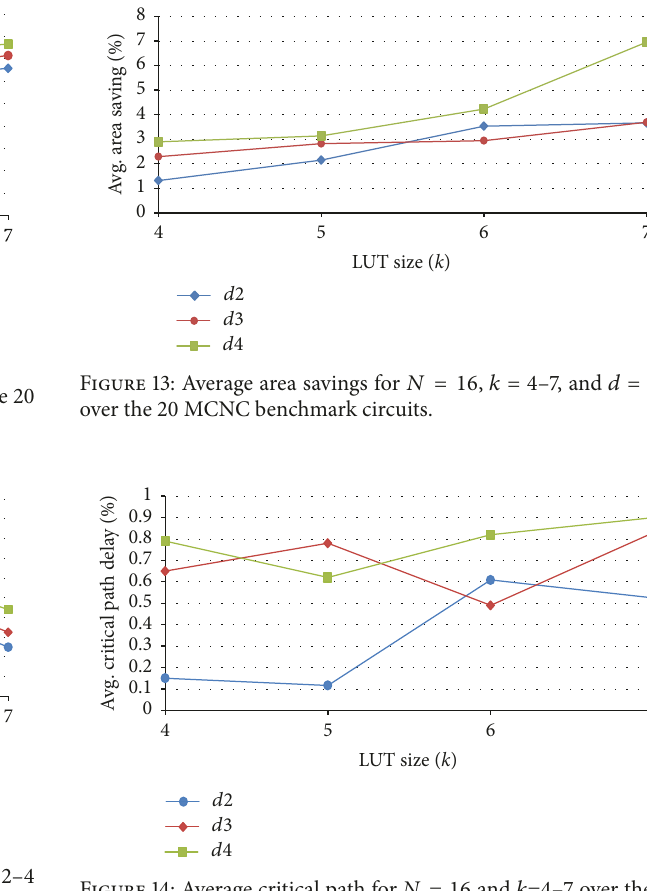
Figure 14: Average critical path for 𝑁 = 16 and 𝑘 =4–7 over the 20 MCNC benchmark